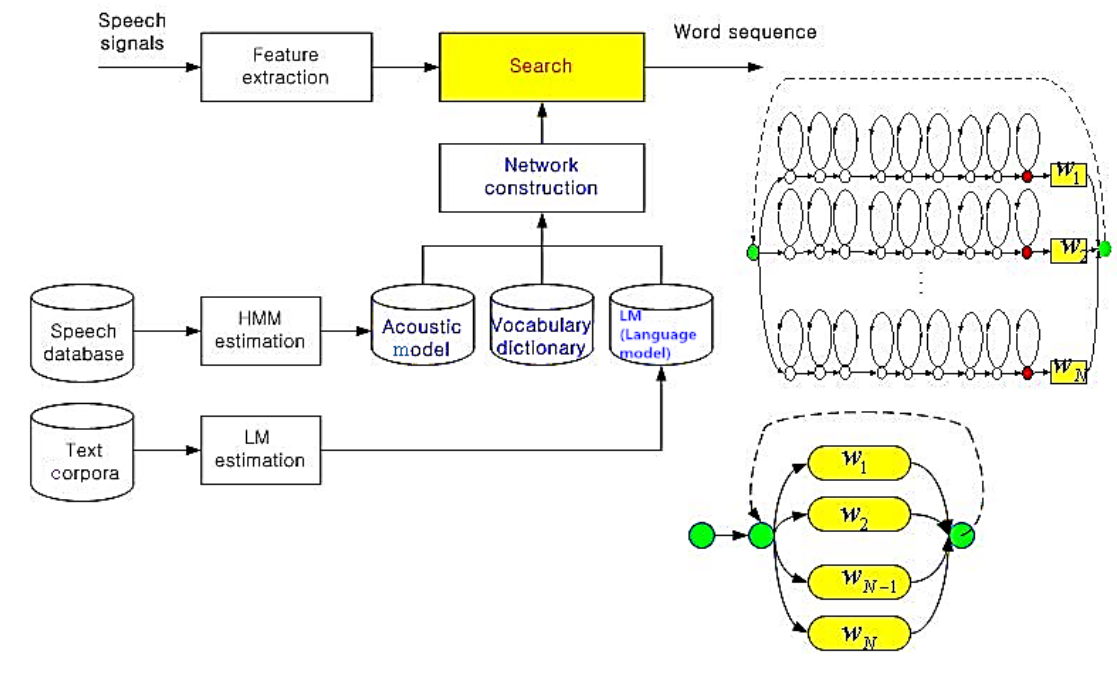
Figure 2. References use templates as word units. HMM: Hidden Markov